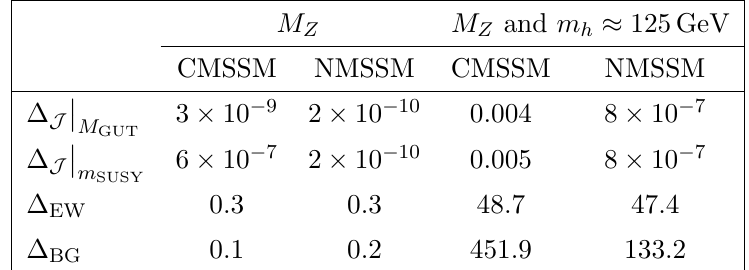
Table 3. Minimum (cid:12)ne-tuning measures (de(cid:12)ned in section 4.3) found in our scans with only M Z in the likelihood and with the requirement that m h